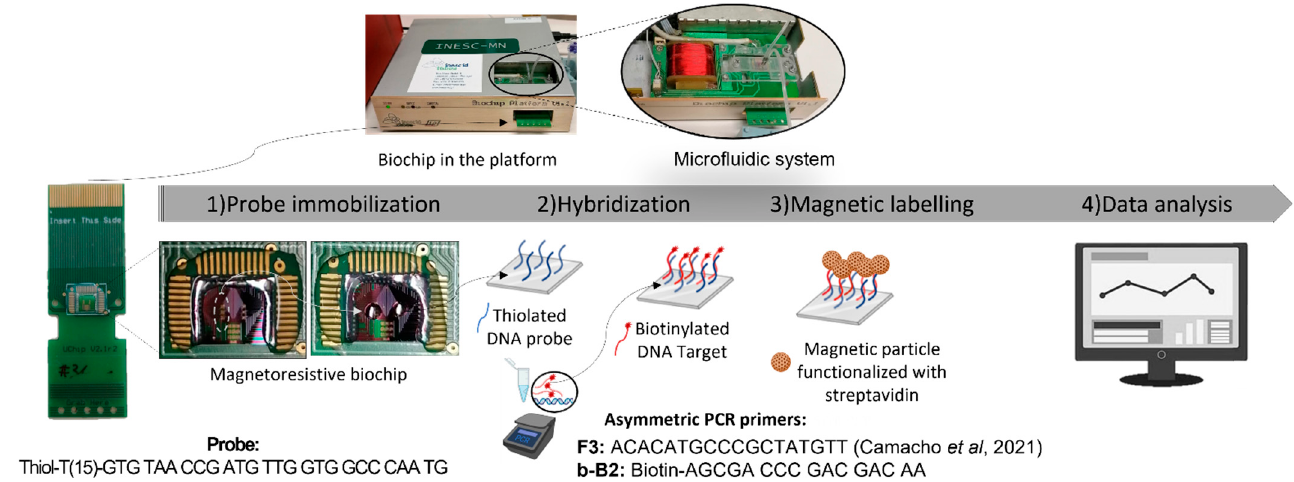
Figure 1. Schematic representation of the main steps involved in a measurement.